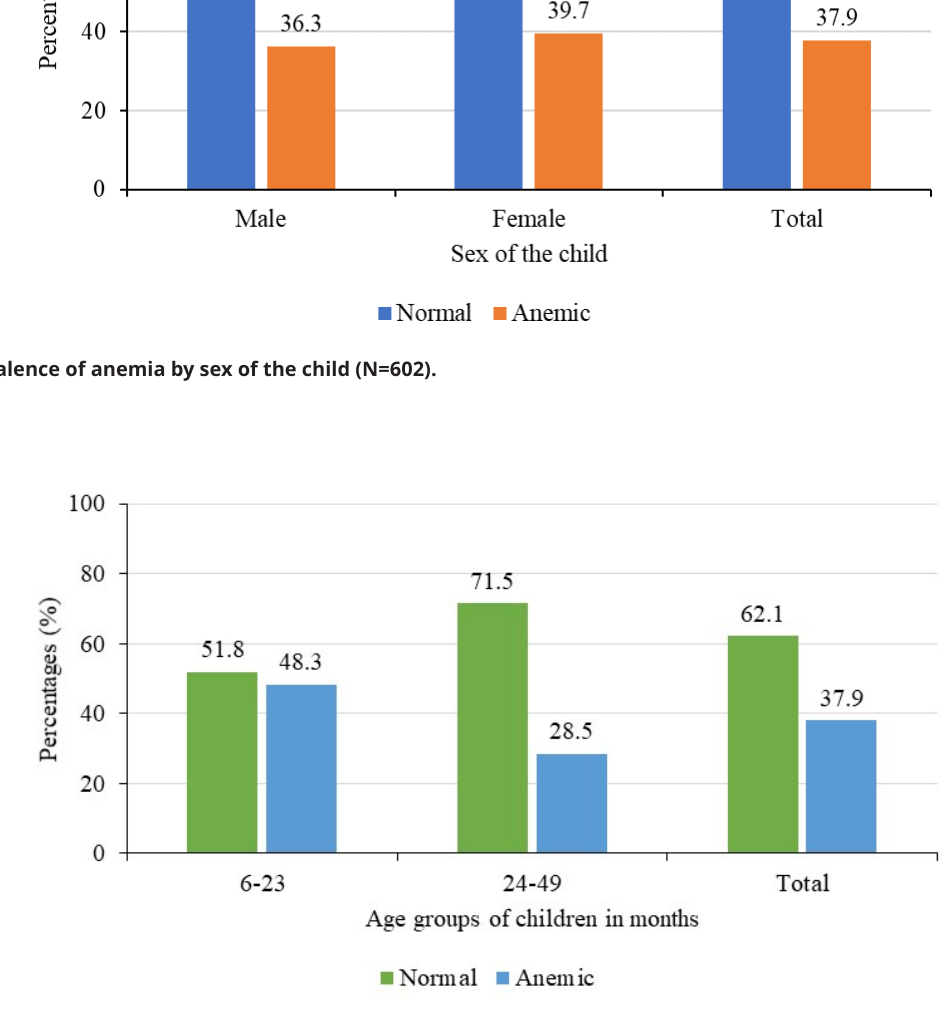
(<24 months) are consistently reported to be at higher odds